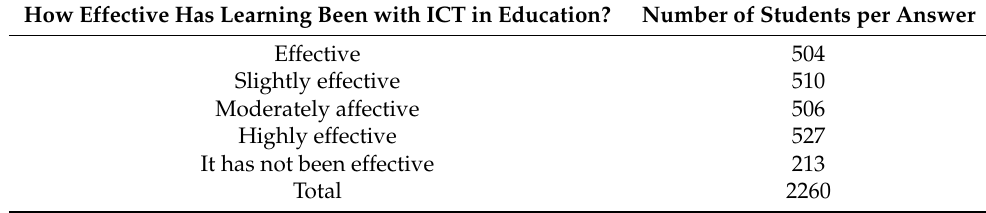
Table 13. Sentiment identified in a survey on the use of ICT in